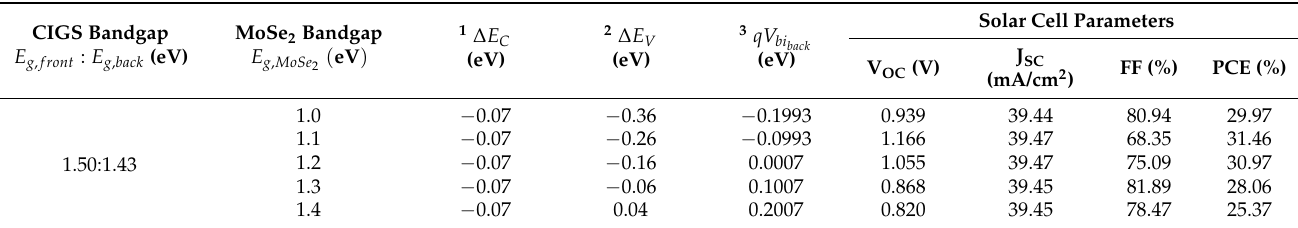
Table 8. Solar Cell Parameters for Different Front and Double Grading Combinations Extracted from Simulated J-V Reported in SRH and Radiative Recombination Profiles (Right